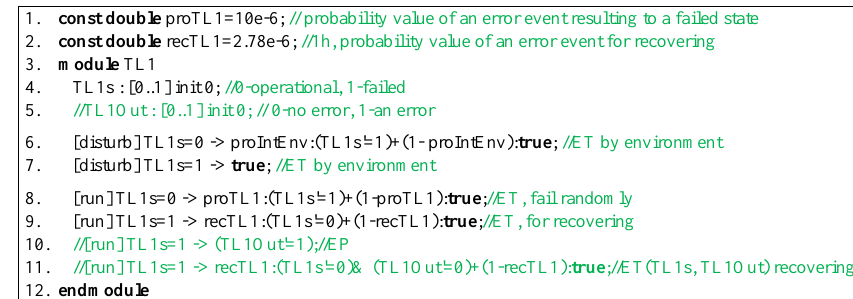
Figure 5. The PRISM-games model of PMS1 system component.